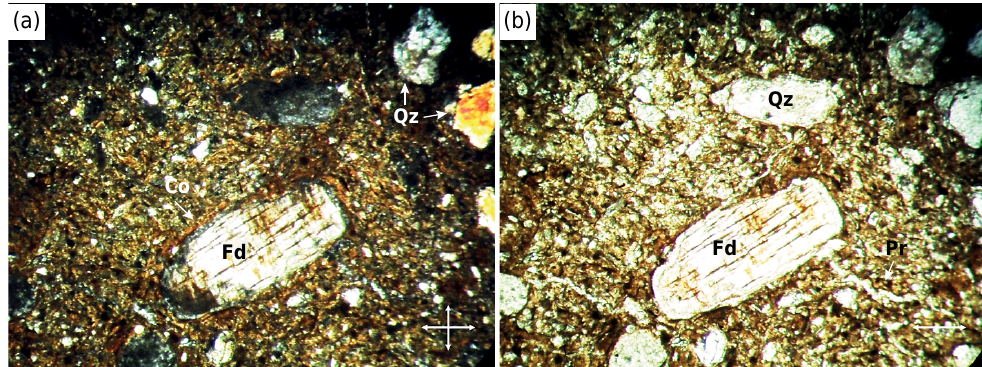
Figure 5. Photomicrographs images of Cvng layer in the Vertisol profile [(a): cross-polarized light; (b): natural light]. The presence of quartz (Qz) and feldspar grains (Fd) composed the coarse material and features of coating